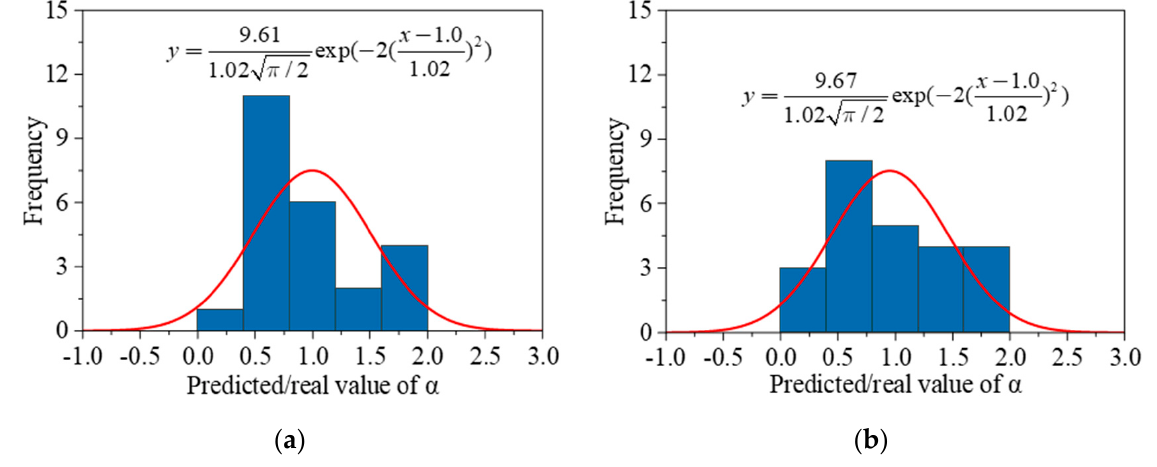
Figure 25. The probability distribution of prediction accuracy in terms of α , ( a ) model prediction from w / c ; ( b ) model prediction from original compressive strength.